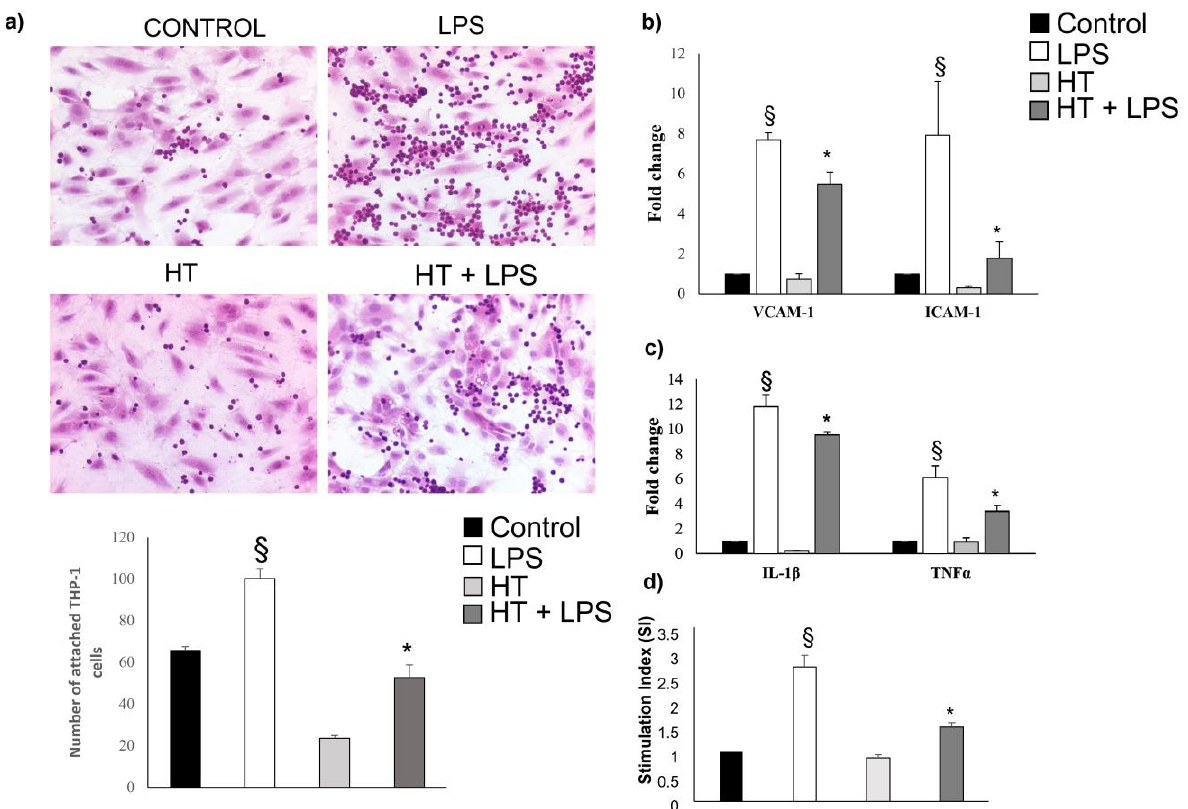
Figure 8. HT decreases LPS-induced adhesion and inflammatory responses in endothelial cells. ( a ) The figure shows the ability of monocytes to adhere to inflamed HUVECs. The administration of HT results in a decrease in monocyte adhesion to inflamed cells. Representative fields of hematoxylin– eosin-stained samples (10X magnification). Expression of ( b ) ICAM-1/VCAM-1 and ( c ) IL-1 β /TNF- α was measured by qPCR. ( d ) ROS production decreases significantly in activated HUVEC cells treated with 50 µ M HT. All results are expressed as means ± S.E.M. of six independent experiments. § p < 0.001 vs. control cells; * p < 0.05 vs. LPS-treated cells.